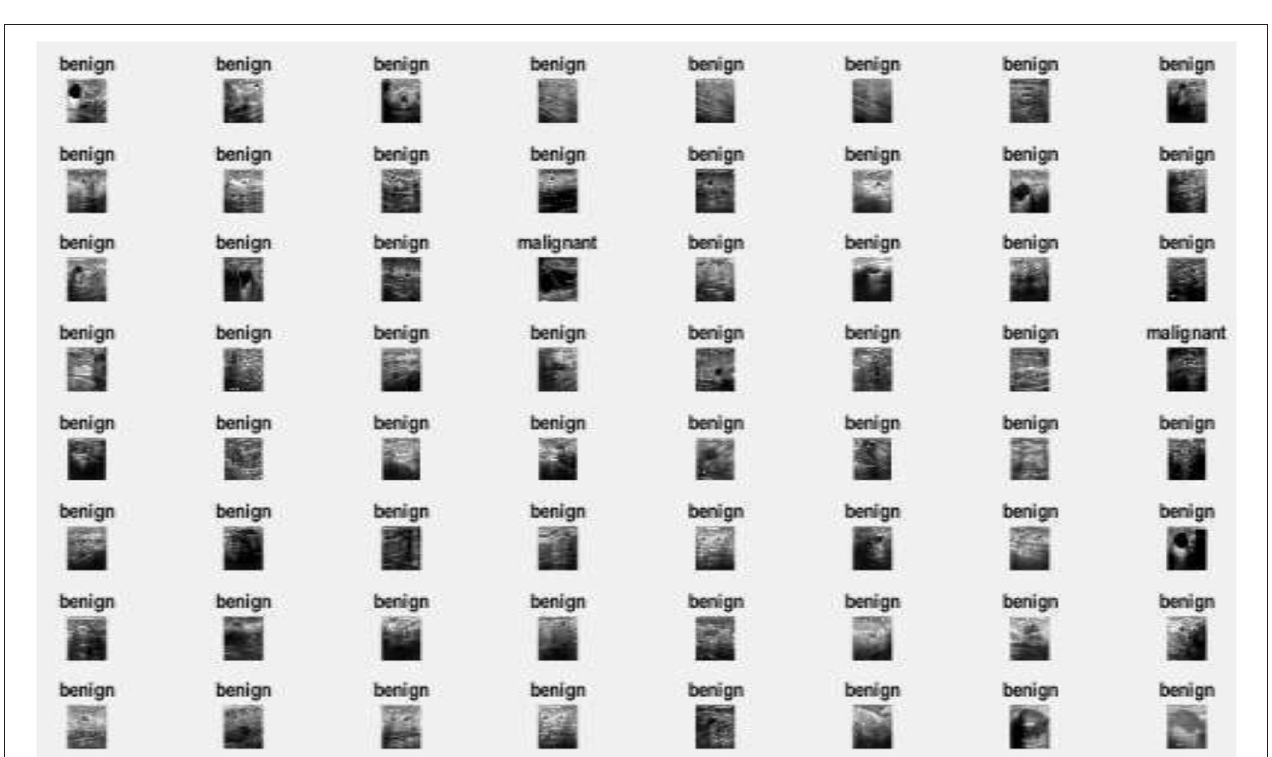
FIGURE 8 | Image classification of dataset